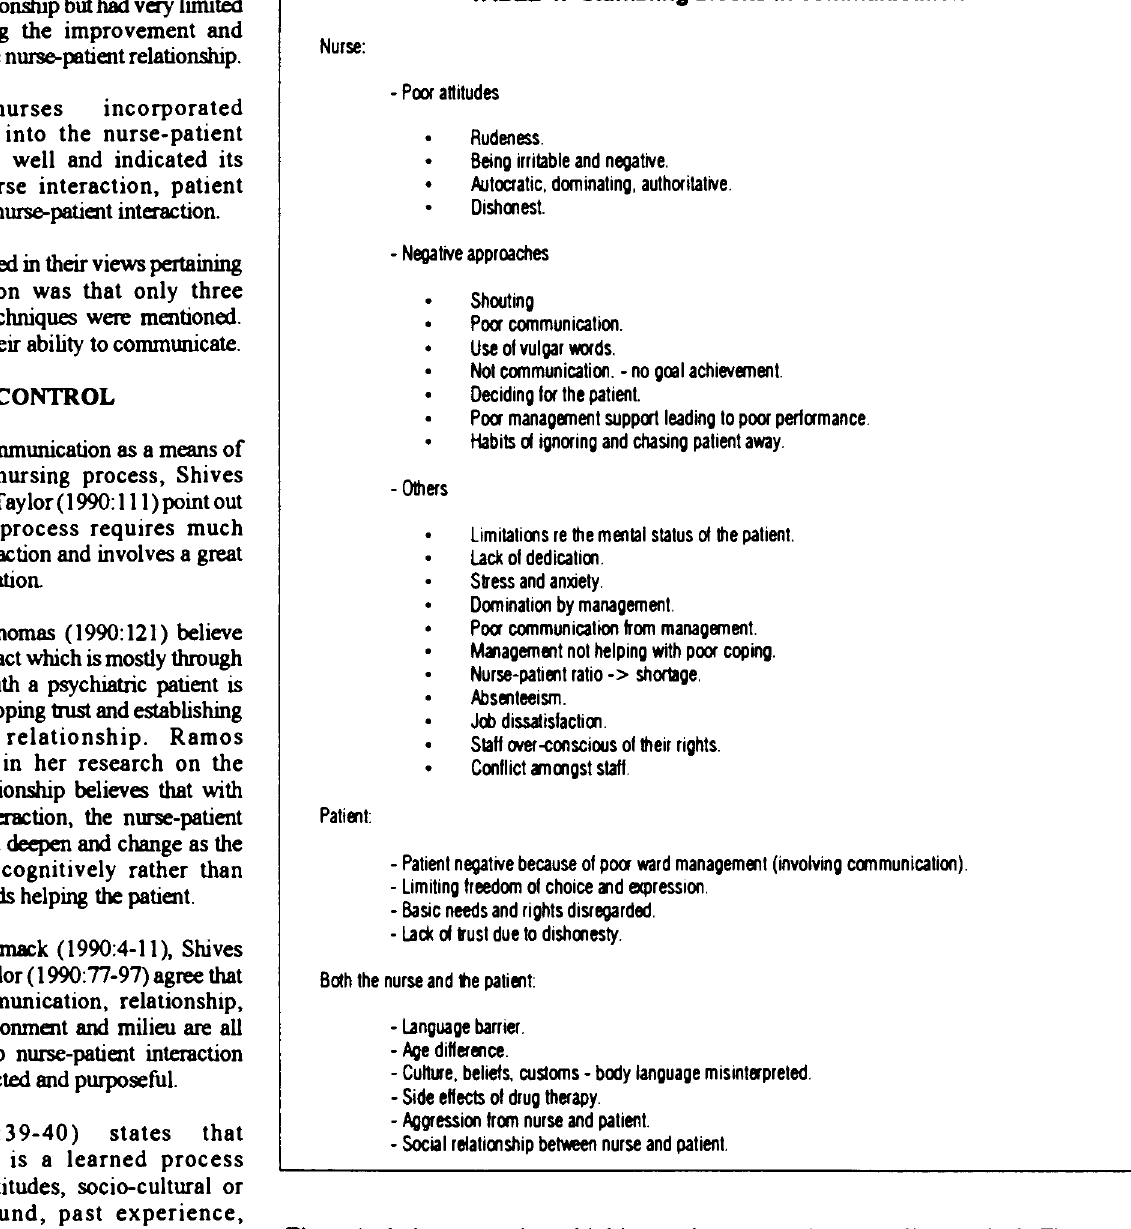
TABLE 4. Stumbling blocks In communication Nurse; - Poor attitudes Rudeness. Being irritable and